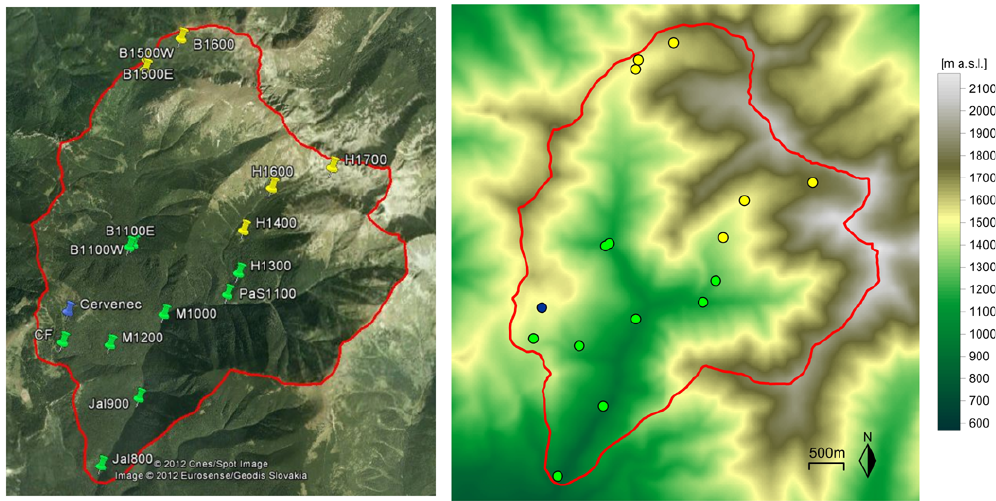
Fig. 2. Topography (screenshot from Google Earth left, digital elevation model right) and location of snow course profiles in the Jalovecky creek catchment. Measurements in the forest and open areas are indicated by green and yellow color, respectively. The blue symbol indicates